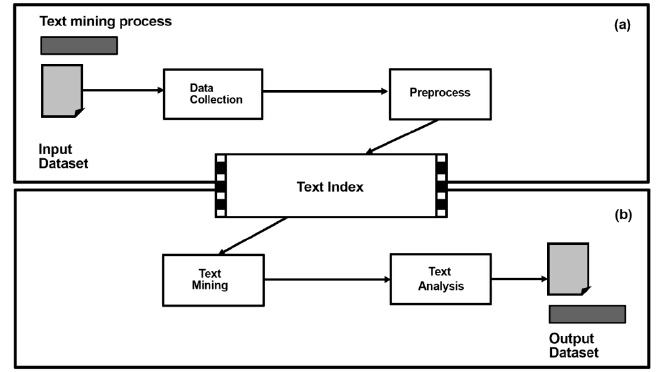
Figure 2. Text mining process. Source: Reproduced with permission from Saura and Bennett [2], Symmetry; published by MDPI, 2019.